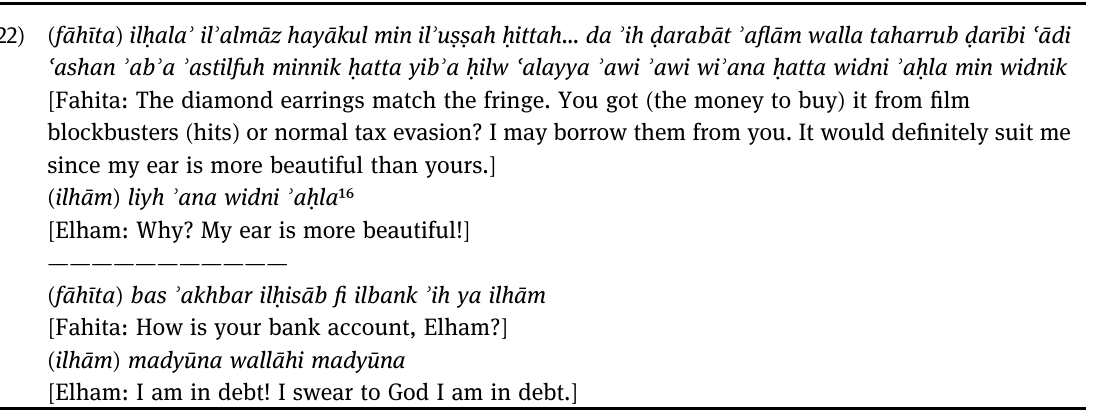
Fahita directed a similar question to Rania who is known to be very proli fi c as she acts in both TV series and fi lms every year ( 23 ) . Fahita, in reference to Rania ’ s accumulating wealth, used a quite common metaphor in Colloquial Egyptian in which getting a lot of money is depicted as the rolling of dice. This metaphor may also evoke an intertexual link with a famous folk song which was a hit at the time Rania ’ s episode was fi rst broadcasted.